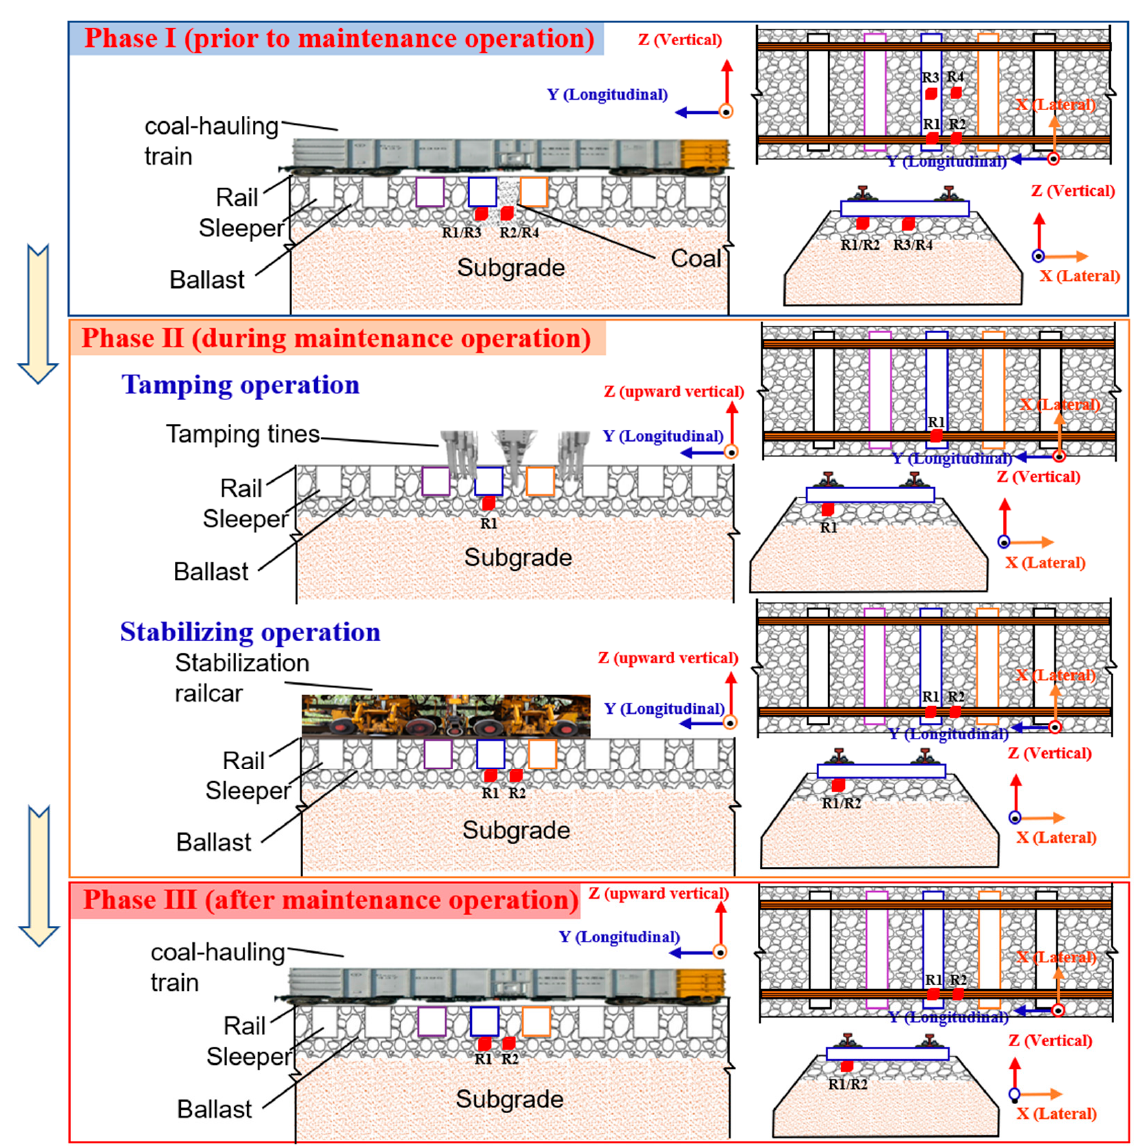
Figure 6. Schematic diagram of the locations of instrumented SR sensors in the ballast bed during three different phases of the field test.